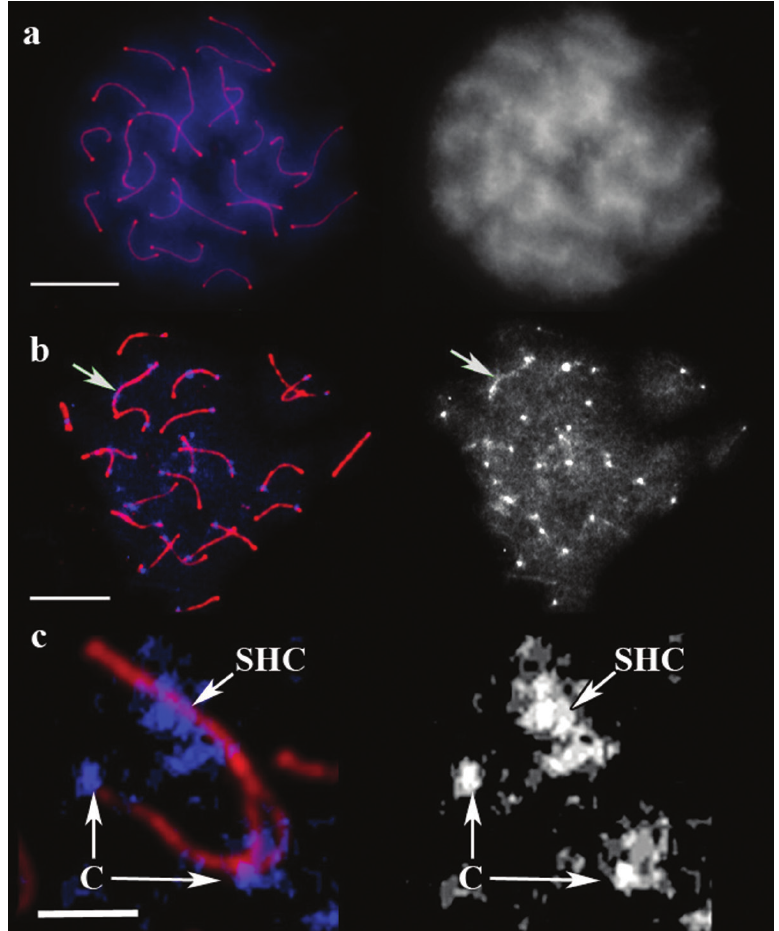
Figure 4. SC spread in guppy. a A cell after immunostaining, prior to barium hydroxide treatment . Left: Red shows SCs, and blue represents DAPI. Right: the same image, DAPI channel separately. Scale bar = 20 µm. b The cell after 5 min of barium hydroxide treatment. Left: Red shows SCs, and blue represents DAPI. Right: the same image, DAPI channel separately. Arrow indicates sex bivalent. Scale bar = 20 µm. c Sex bivalent during pairing. Red shows SC, blue represents DAPI. C: centromere, SHC: sex hetero- chromatin. Scale bar = 5